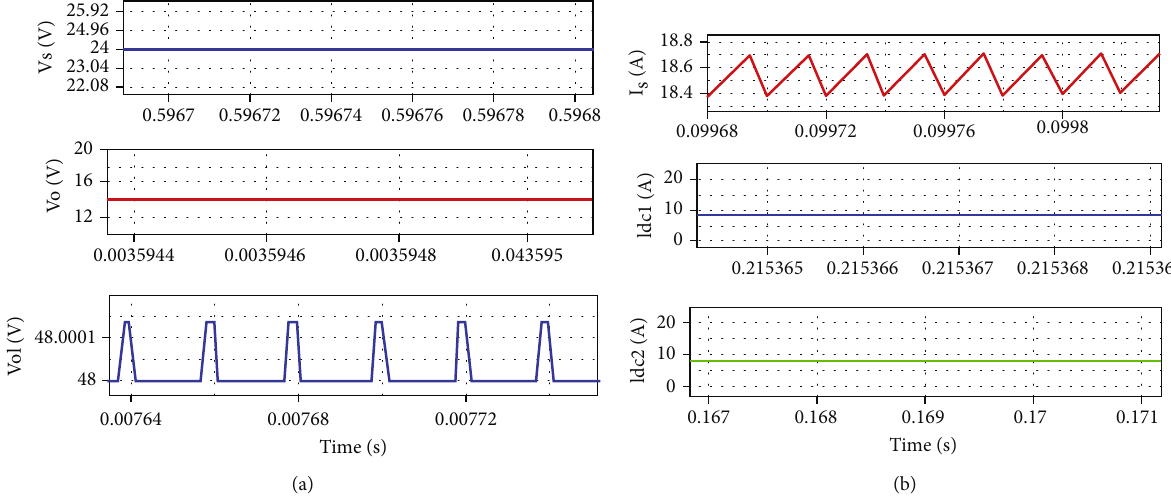
V V o and o 1 half-bridge BDC in buck mode and (b) current